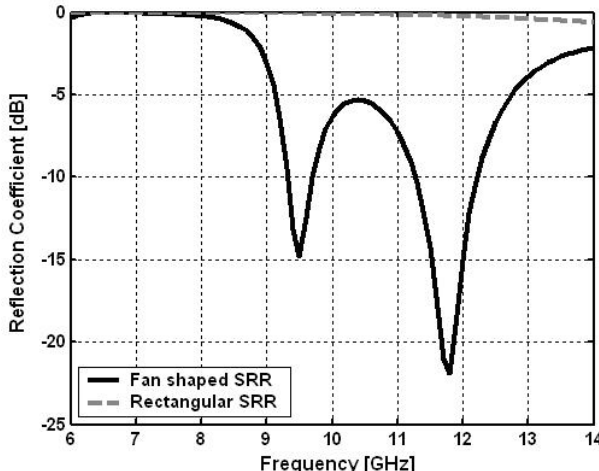
Figure 4: The simulated reflection coefficient of rectangular SRR and fan shaped SRR metamaterial absorber for cross- polarized wave.